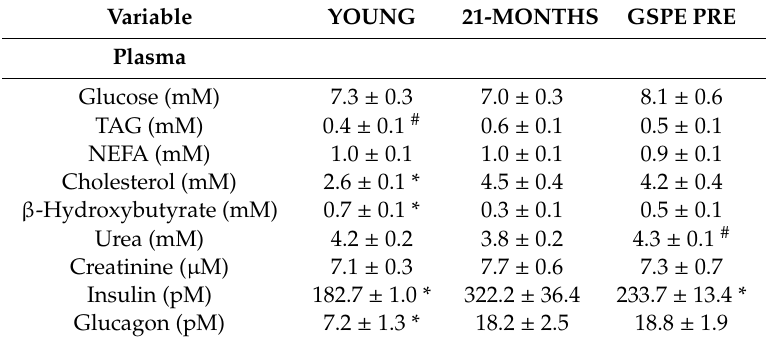
Table 2. Plasma biochemical characteristics at the end of the experiment (week